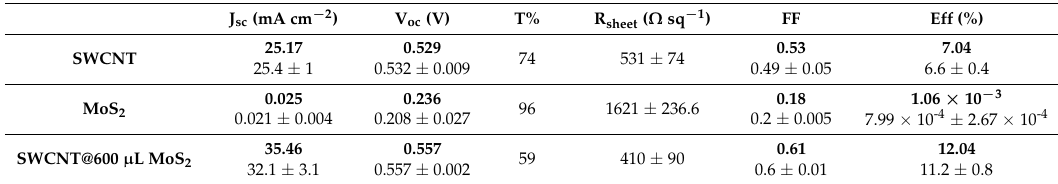
Table 1. Selected solar cell and diode properties for SWCNTs, MoS 2 and SWCNT/MoS 2 . Data shown for champion cells (bold typeface) and average properties with standard deviation (regular typeface). Three devices of such type are included in the analysis.